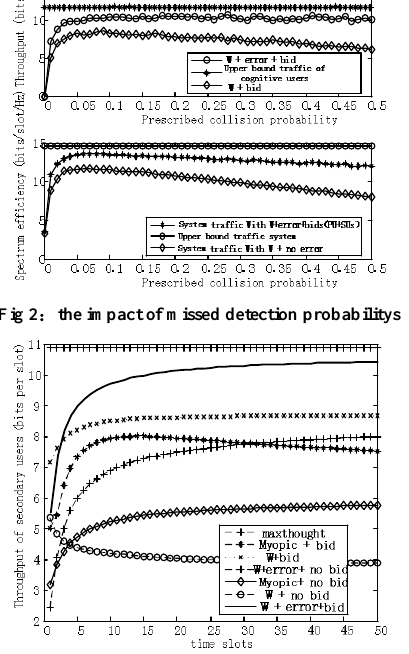
Fig 2 ： the impact of missed detection probabilitys